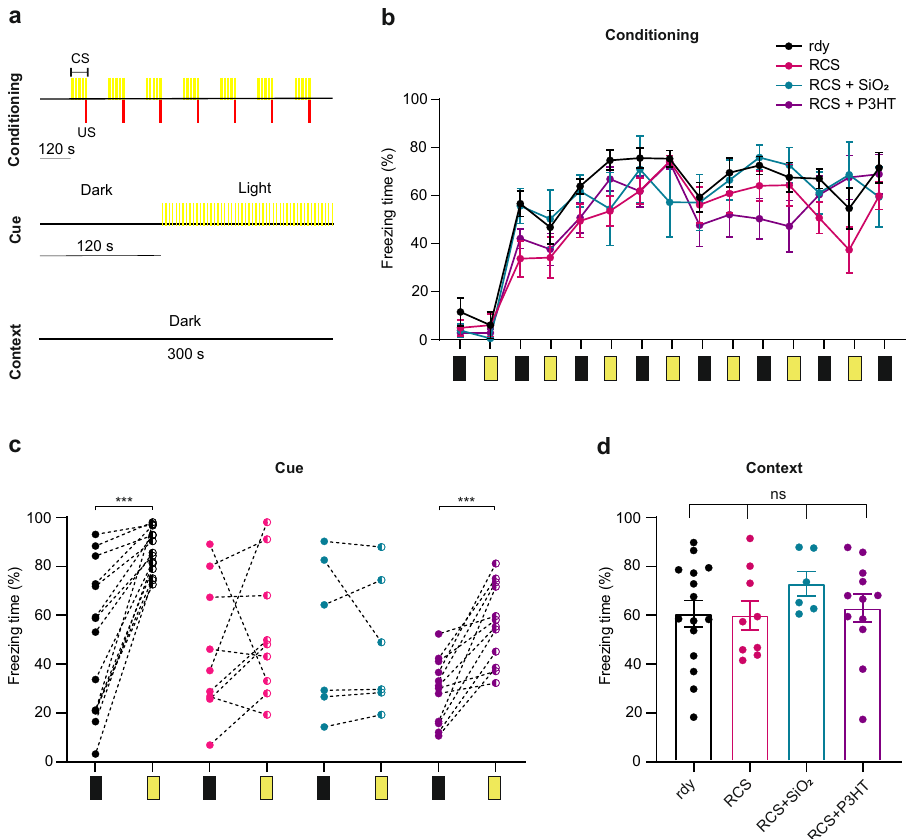
Fig. 8 Recovery of light perception in aged RCS rats injected with P3HT-NPs as evaluated by classical conditioning. a Schematic representation of conditioning cue and context protocols. Top : During the conditioning session, rats were placed in the dark chamber of the apparatus for 2-min habituation and then subjected for 9 min to seven combinations of a conditioned stimulus (CS; light fl ashes at 5 Hz, see Methods) paired with an unconditioned stimulus (US; mild footshock). Middle: During the cue test session, rats underwent 2-min habituation in the dark to explore the novel context, after which 3 min of CS were presented. Bottom : During the context session, rats were placed in the dark for 5 min to explore the same context of the conditioning session without the presentation of the CS-US. b Acquisition of a conditioned fear reaction to a light stimulus in healthy 11-month-old rdy controls and age- matched RCS rats that were untreated or subretinally injected with either P3HT-NPs or SiO 2 -NPs. In the conditioning session, freezing recorded during each CS-US pairing progressively increased in all experimental groups. c The light-conditioned freezing behavior recorded in the cue test session increased in healthy rdy and P3HT-NP injected RCS rats, while untreated or sham-injected RCS rats did not show any freezing response. *** p < 0.001, paired Student ’ s t -test. d Freezing behavior recorded in the context test session did not differ among the experimental groups. ns, not signi fi cant; one-way ANOVA/Tukey ’ s tests. Data are means ± sem with superimposed individual experimental points. Black rectangles indicate dark time intervals; yellow rectangles represent the CS. Sample size: n = 15, 9, 6 and 12 for rdy, RCS, RCS + SiO 2 and RCS + P3HT, respectively. For exact p -values and source data, see Source data